Question: Which visualization type does this figure use?
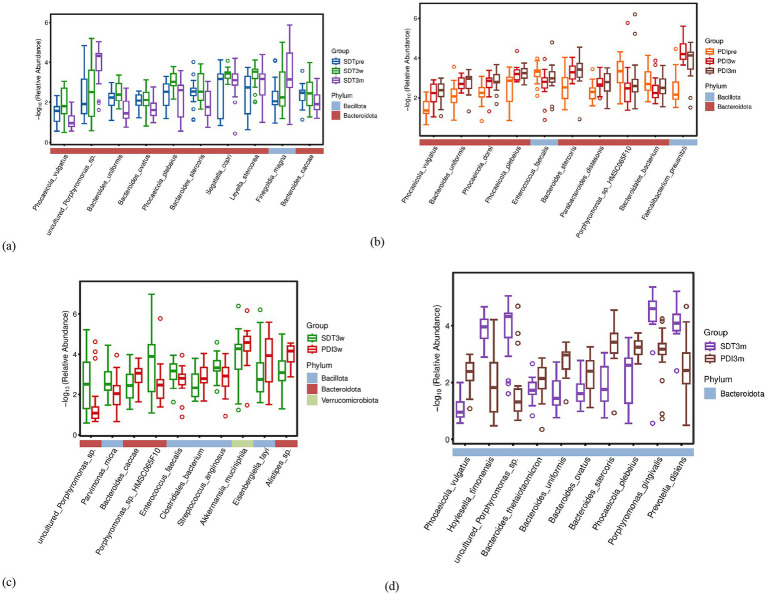
Answer: box